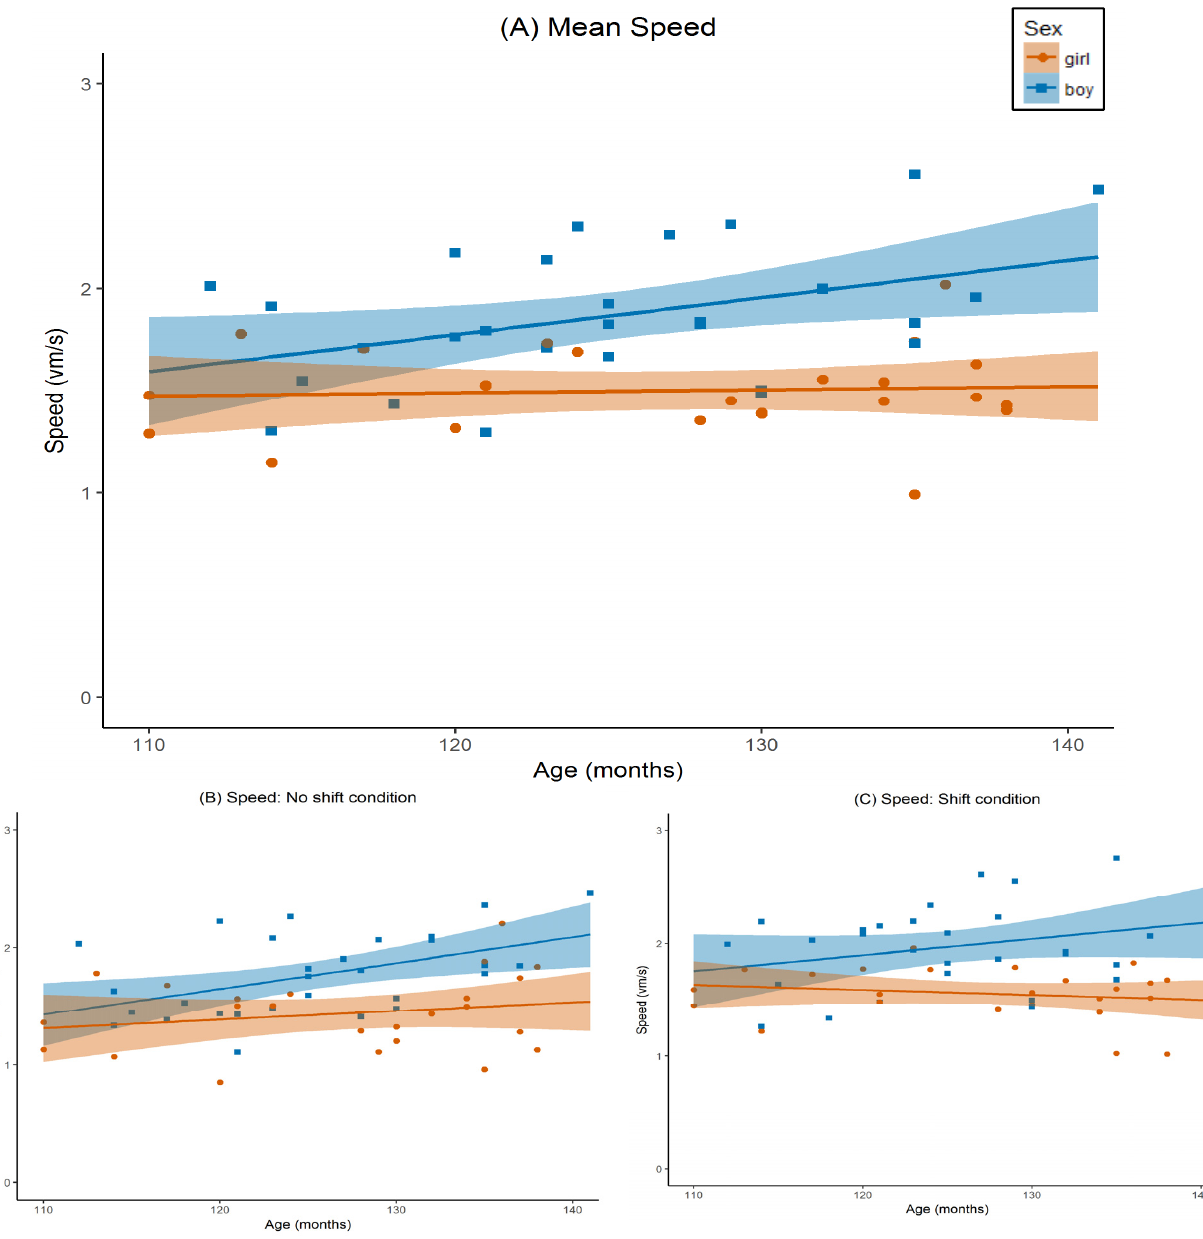
Figure 4. Speed by age for boys and girls. Speed represents average navigational speed of the player in the testing phase in virtual meters per second (vm/s). Age was measured in months. The graph is separated by sex: orange circles represent girls, blue squares represent boys. Lines represent the regression line, separated by sex (orange for girls, blue for boys). Shaded area around the regression line represents standard error. ( A ) Mean speed over both trial types (’no shift’ and ‘shift’). ( B ) Speed for the ’no shift’ condition. ( C ) Speed for the ‘shift’ condition.